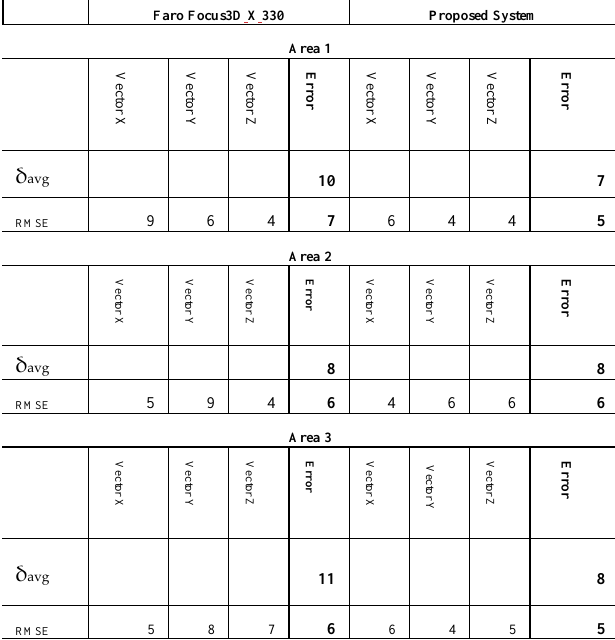
Table 2. Errors made by the laser scanner(left) and our proposed system (right) process. Euclidean average distance error(δavg) and Root Mean Square Error (RMSE) have been calculated for the three areas of